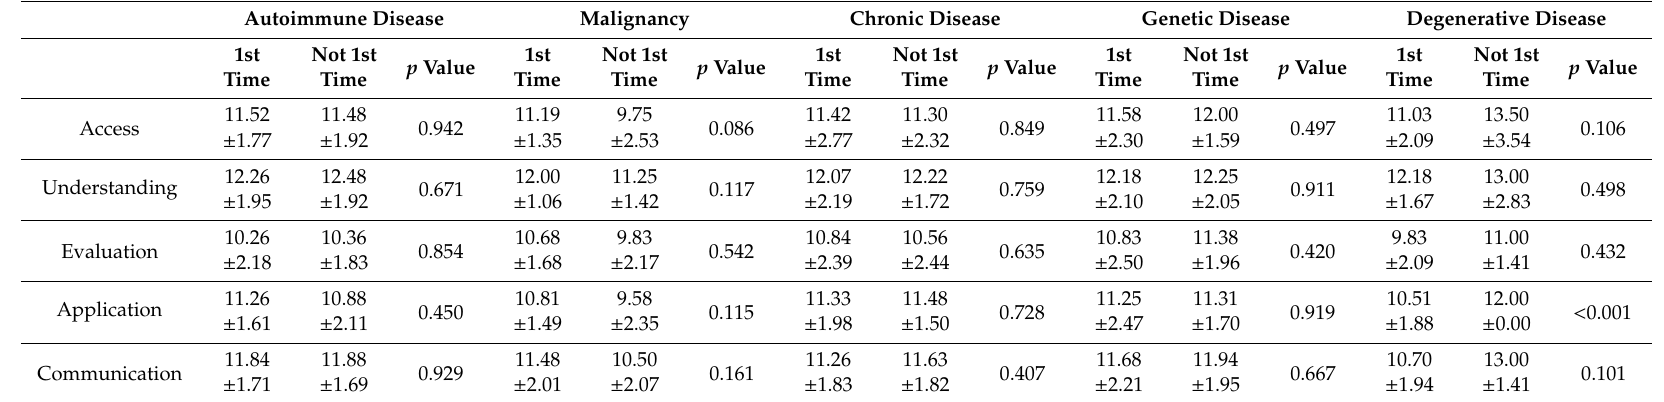
Table 2. The association between first-time participation and all dimensions of MMHLQ divided by types of